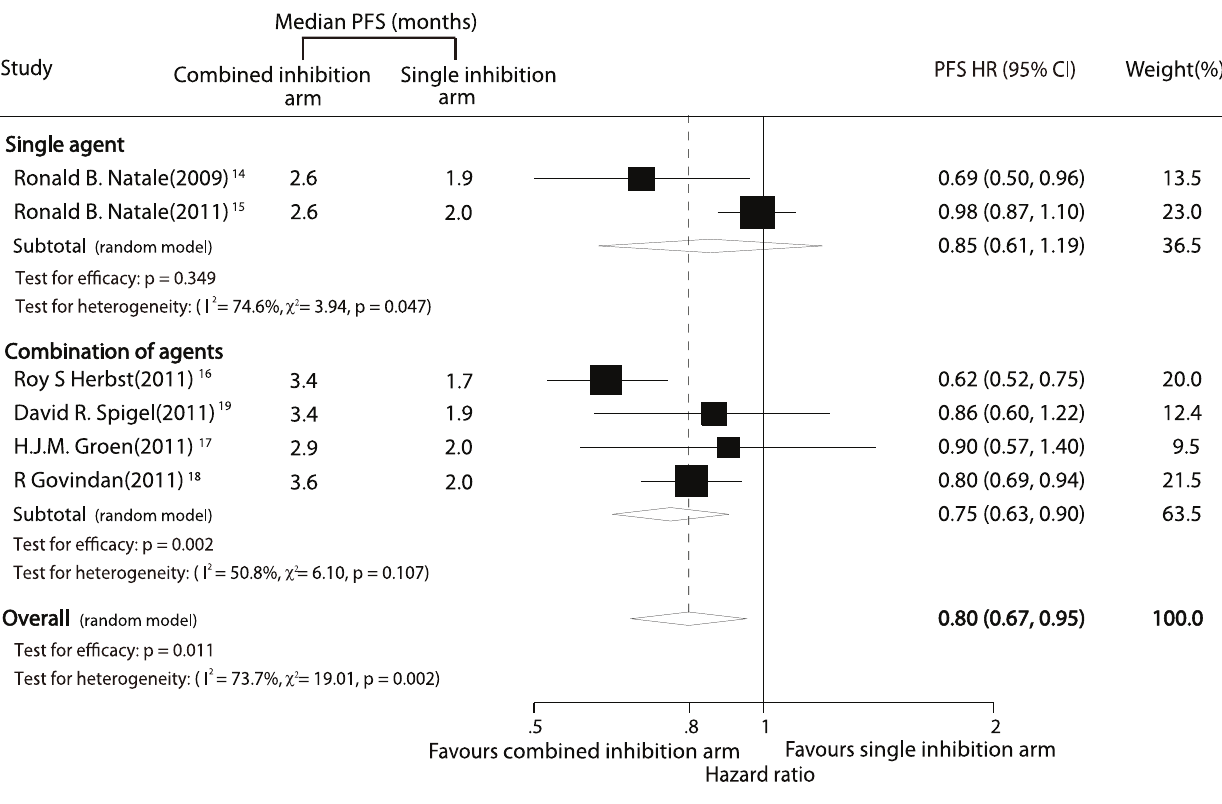
Figure 3. Comparison of progression-free survival between combined inhibition therapy and single inhibition therapy.